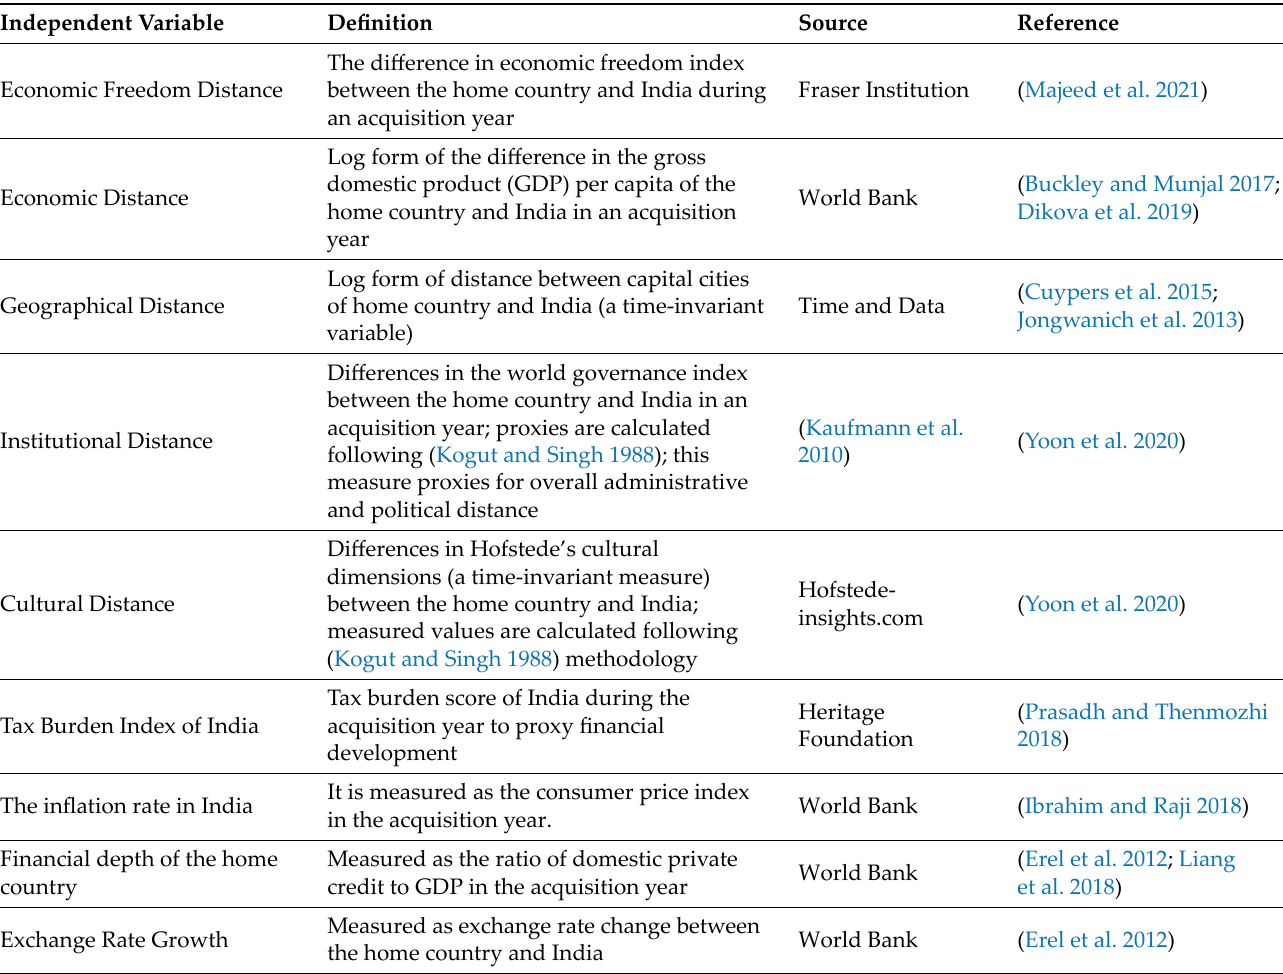
Table 1. Measurement units and sources of all independent